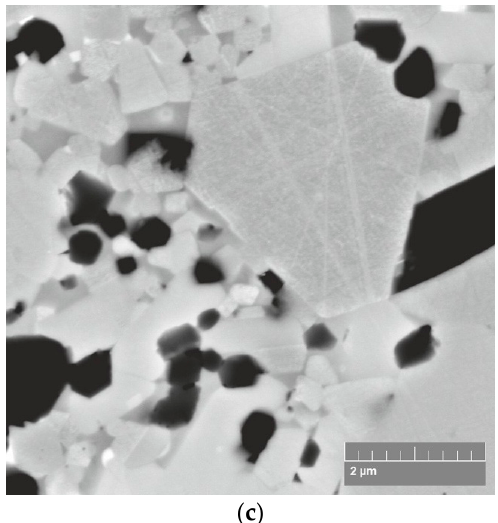
Figure 5. SEM micrographs of composites SPSed at: 1350 °C ( a ); 1400 °C ( b ) and 1450 °C ( c ).